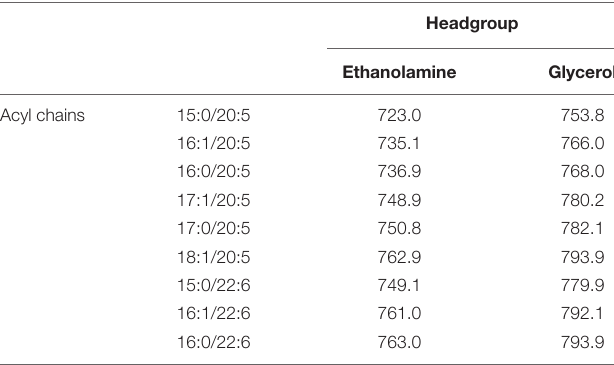
TABLE 2 | Representative m/z values of [M-H] − ions of EPA- and DHA-containing PLs detected in ESI-MS analysis.